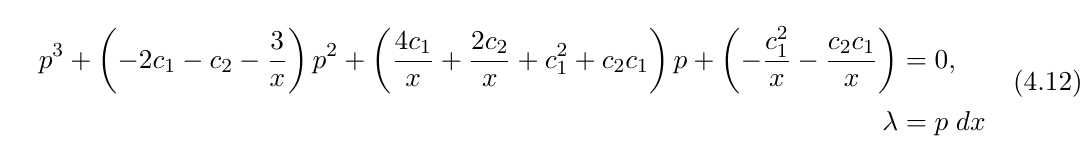
(cid:22) (cid:3) (cid:10)